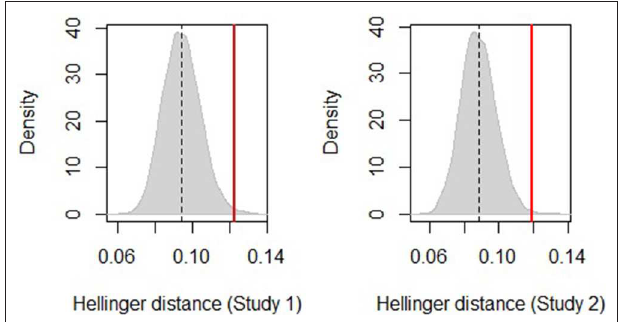
FIGURE 3 | Sampling distribution of distances between the frequency and the probability groups for study 1 the left and study 2 on the right. The vertical red line is the actual Hellinger distance between